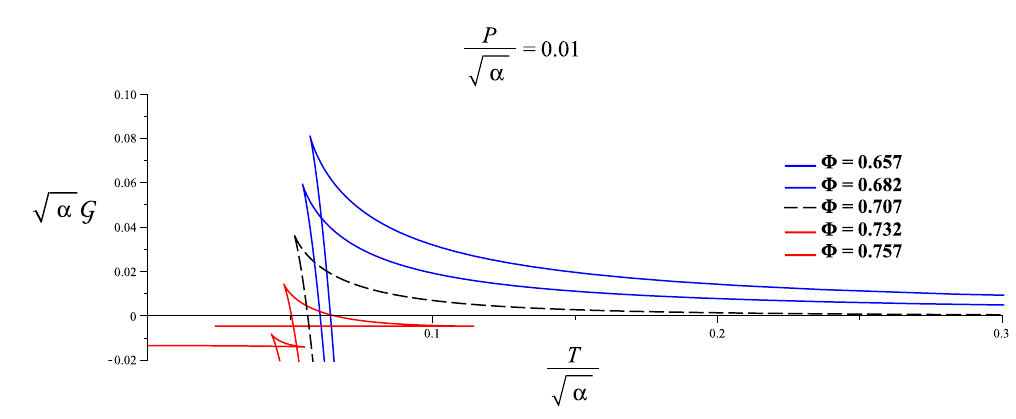
p 2. The critical point (occurring on (cid:8) (cid:25) 0 : 778) is not